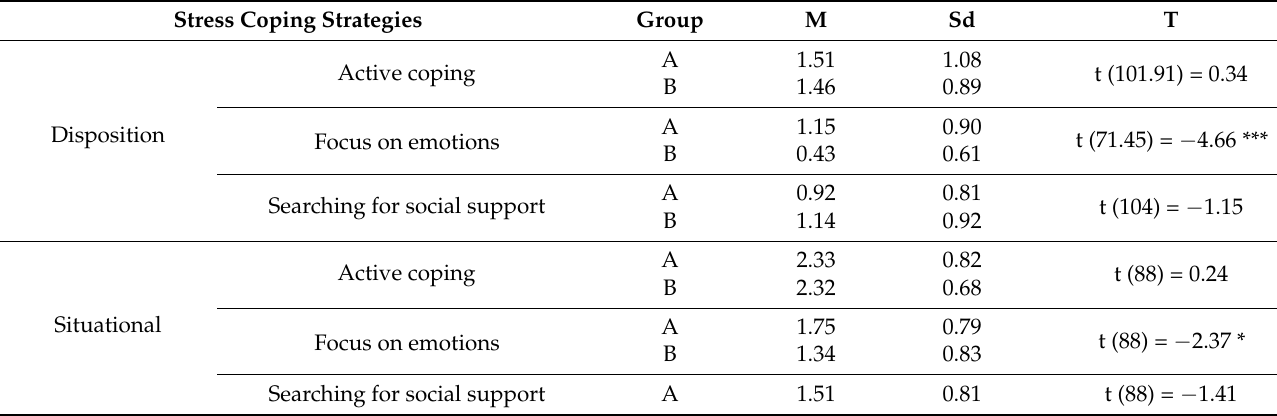
Table 2. Significance of differences between ASD children from families with low and average financial status in terms of preferred strategies of coping with stress.